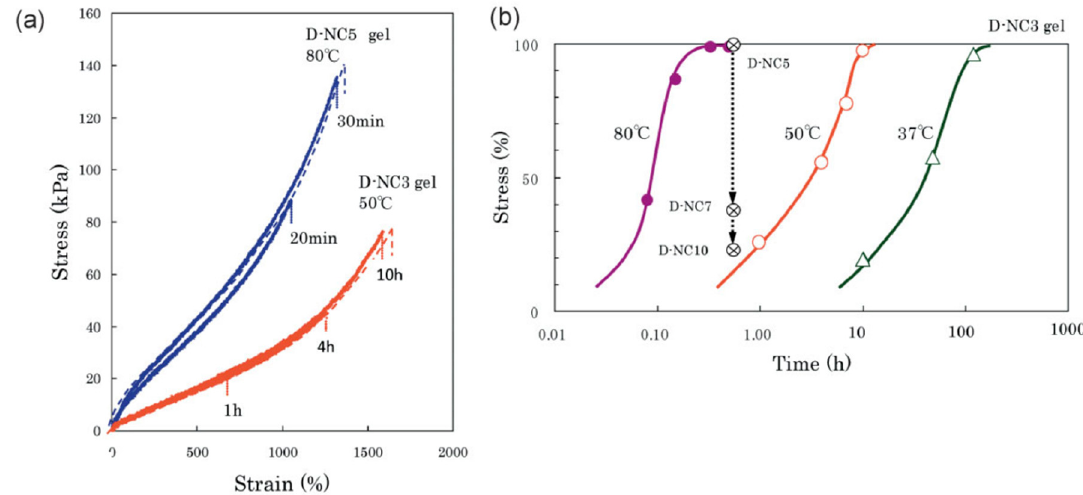
Figure 8. Tensile mechanical properties of self-healed PDMAm/synthetic hectorite nanocomposite hydrogels (D-NCn, where n indicates increasing concentration of hectorite) shown in Figure 7. ( a ) Stress-strain curves of the original and the self-healed gels before (dashed lines) and after (solid lines) cutting. ( b ) Effects of self-healing conditions (time and temperature) on the recovery of tensile strength of self-healed gels. Reprinted with permission from Haraguchi, K.; Uyama, K.; Tanimoto, H. Self-healing in Nanocomposite Hydrogels Macromolecular Rapid Communications 2011 , 32, 1253–1258. Copyright (2011) John Wiley and Sons.